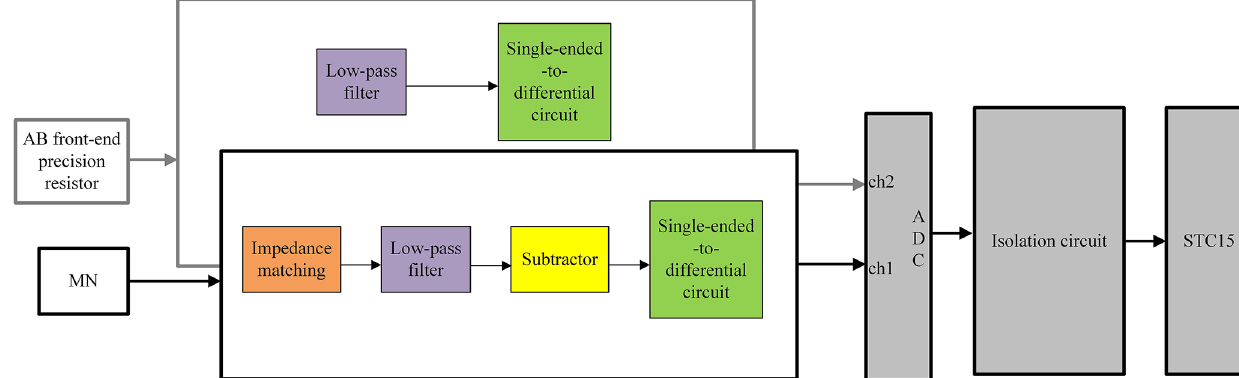
Figure 4. Block diagram of the